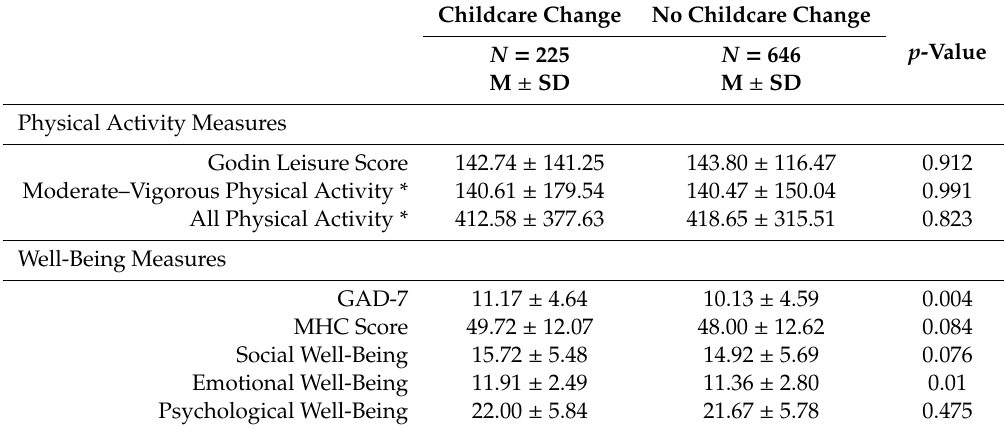
Table 6. t -Tests Results Comparing Women Responsible for Increased Childcare Provision and Women with No Changes to Childcare